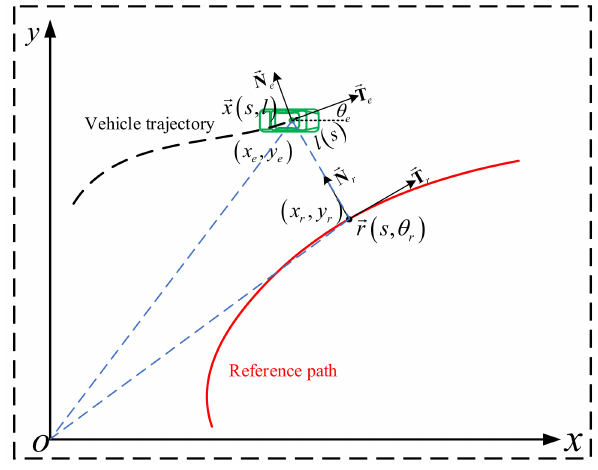
Figure 4. Lateral error description in Frenet coordinate